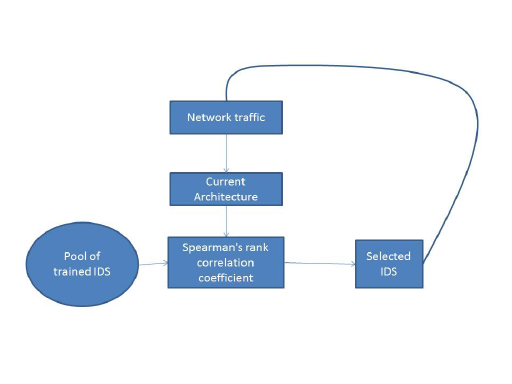
Figure 6. Proposed Adaptive